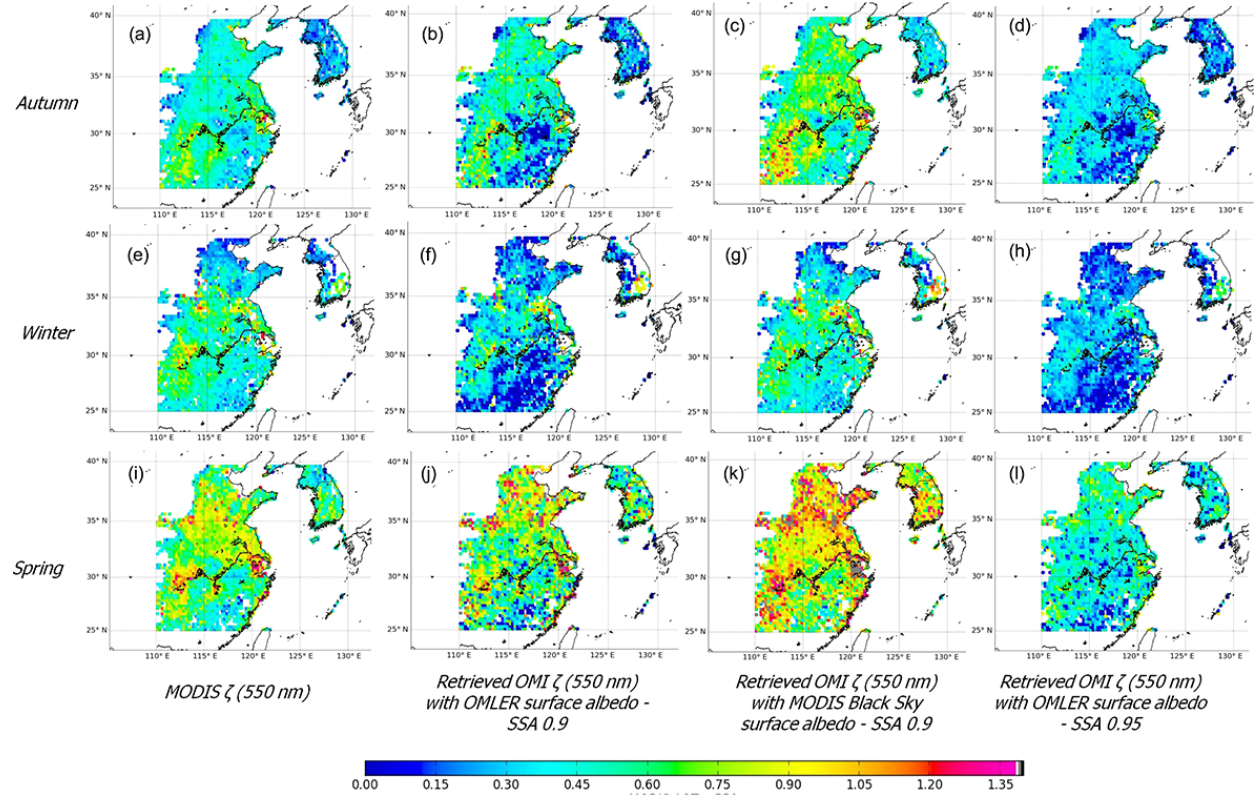
Figure 14. Spatial averages of τ (550nm) values over north-east Asia for cloud-free scenes. Statistics are computed over 3 years, 2005–2007, for the three seasons, autumn, winter and